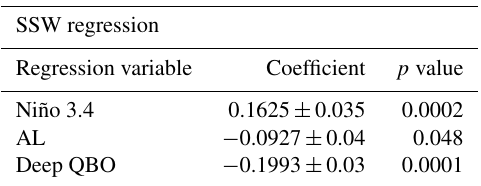
Table 1. Summary of results from regression analysis of SSWs per NH winter time